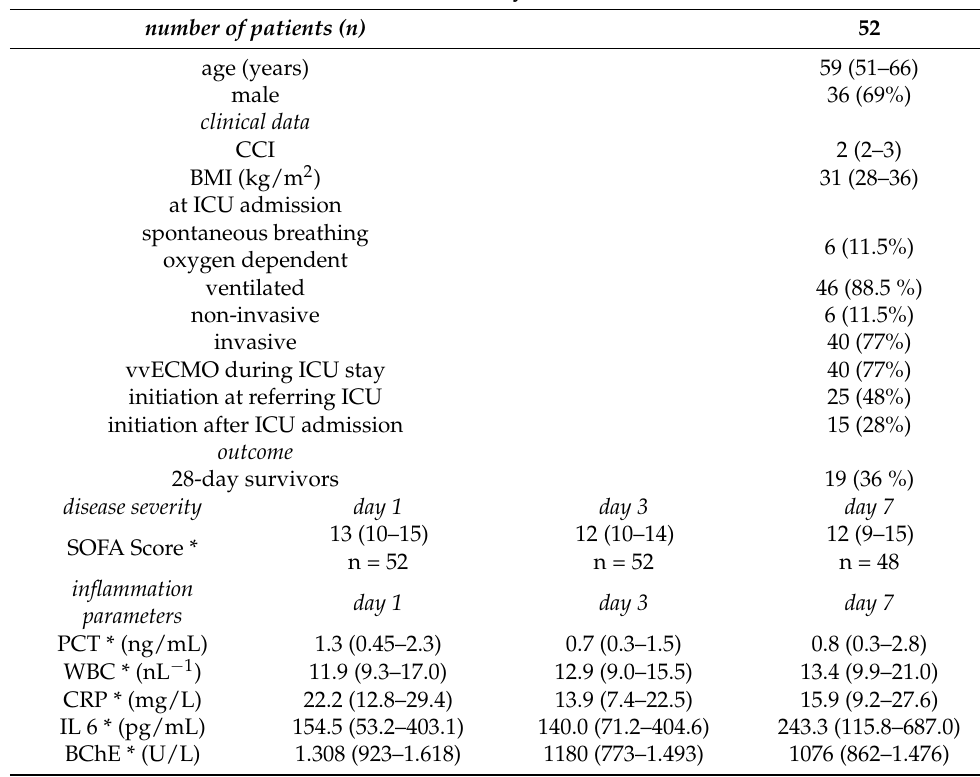
Table 1. Characteristics of critically ill COVID-19 patients. * Median (interquartile range). CCI— Charlson Comorbidity Index; BMI—Body mass index; SOFA—the sequential organ failure assessment score; PCT—procalcitonin; IL 6—Interleukin 6; WBC—white blood cells; CRP—C-reactive protein; vvEVMO—venovenous extracorporeal membrane oxygenation;